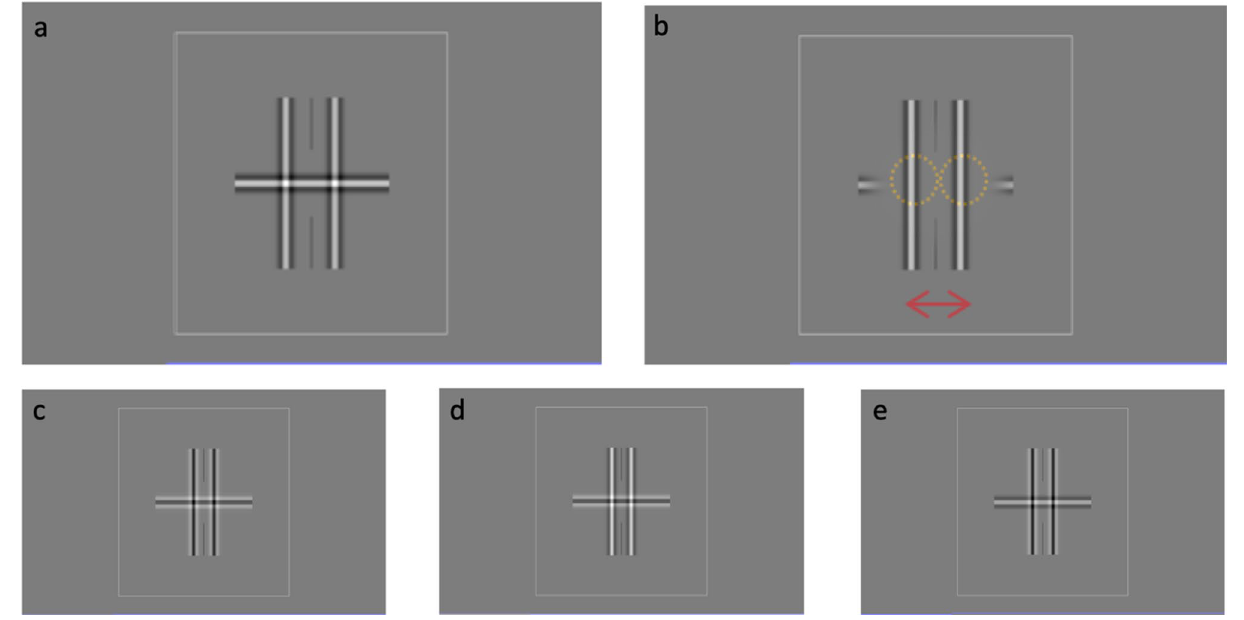
Figure 1. Stimuli used in the experiment. ( a ) The DoG bars had a white center surrounded by a darker grey region on both sides. A white square outline served as the binocular fusion lock. Two fine vertical black lines pointing towards the center part of the reference served as a fixation guide. The horizontal reference bar was presented continuously to one eye. The two vertical suppressors were presented briefly (1 s) to the other eye following a keypress. ( b ) Subjects adjusted the separation of the vertical bars to the widest setting that still suppressed the horizontal segment between them, and could present the suppressors as many times as needed. The distance between the center of the two suppressors is termed as the suppression zone width, (red arrow). An illustration of the area of perceived suppression upon vertical suppressor appearance is outlined by the yellow circles. ( c – e ) These figures illustrate the different combinations of contrast polarity tested in Experiment 2B: ( c ) black–black, ( d ) black–white, and ( e ) white–black. The first color in the combination refers to the center of the horizontal reference followed by the vertical